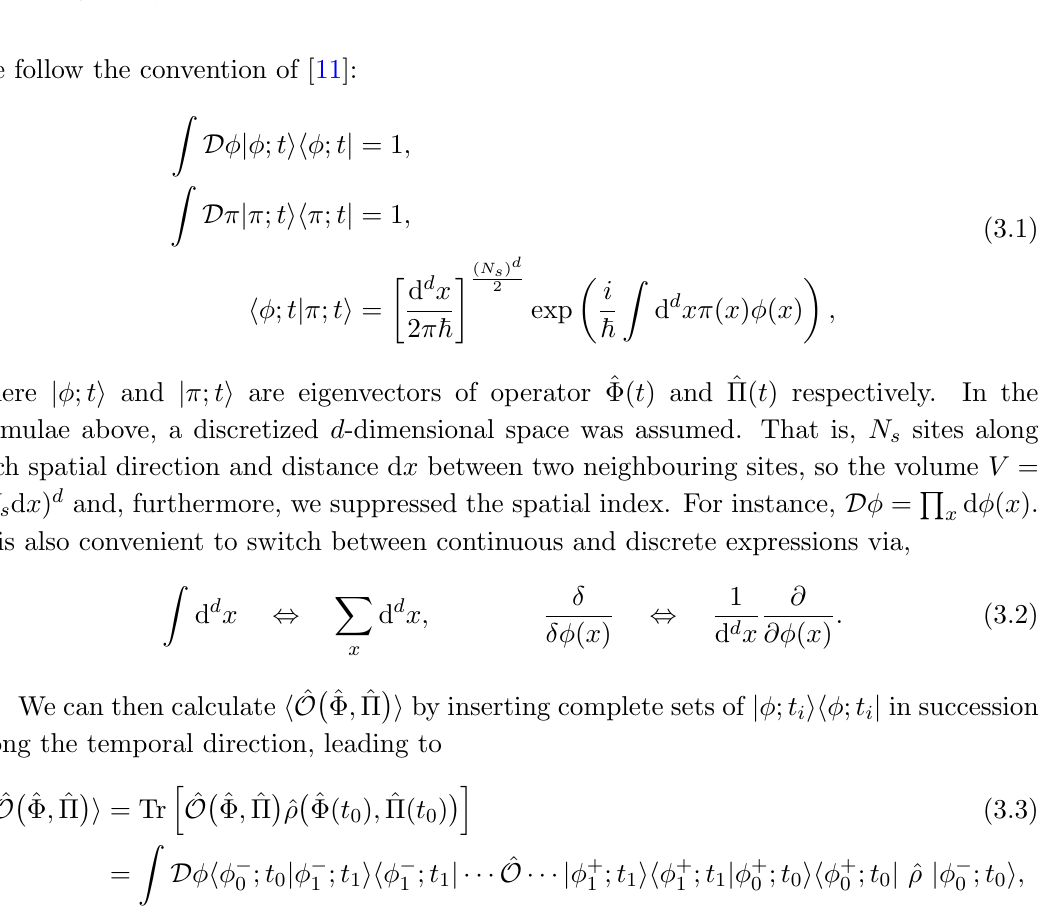
Figure 1 . Illustration of inserted (cid:30) . Here we separate (cid:30) + and (cid:30) (cid:0) vertically for demonstration purpose. All these (cid:12)elds live on the real-time line. The di(cid:11)erence between two neighbouring t is a constant, given by d t